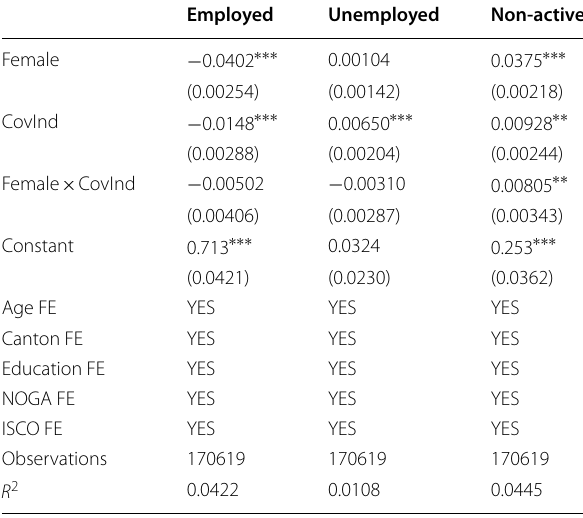
Table 10 Robustness: COVID-19 and labor market